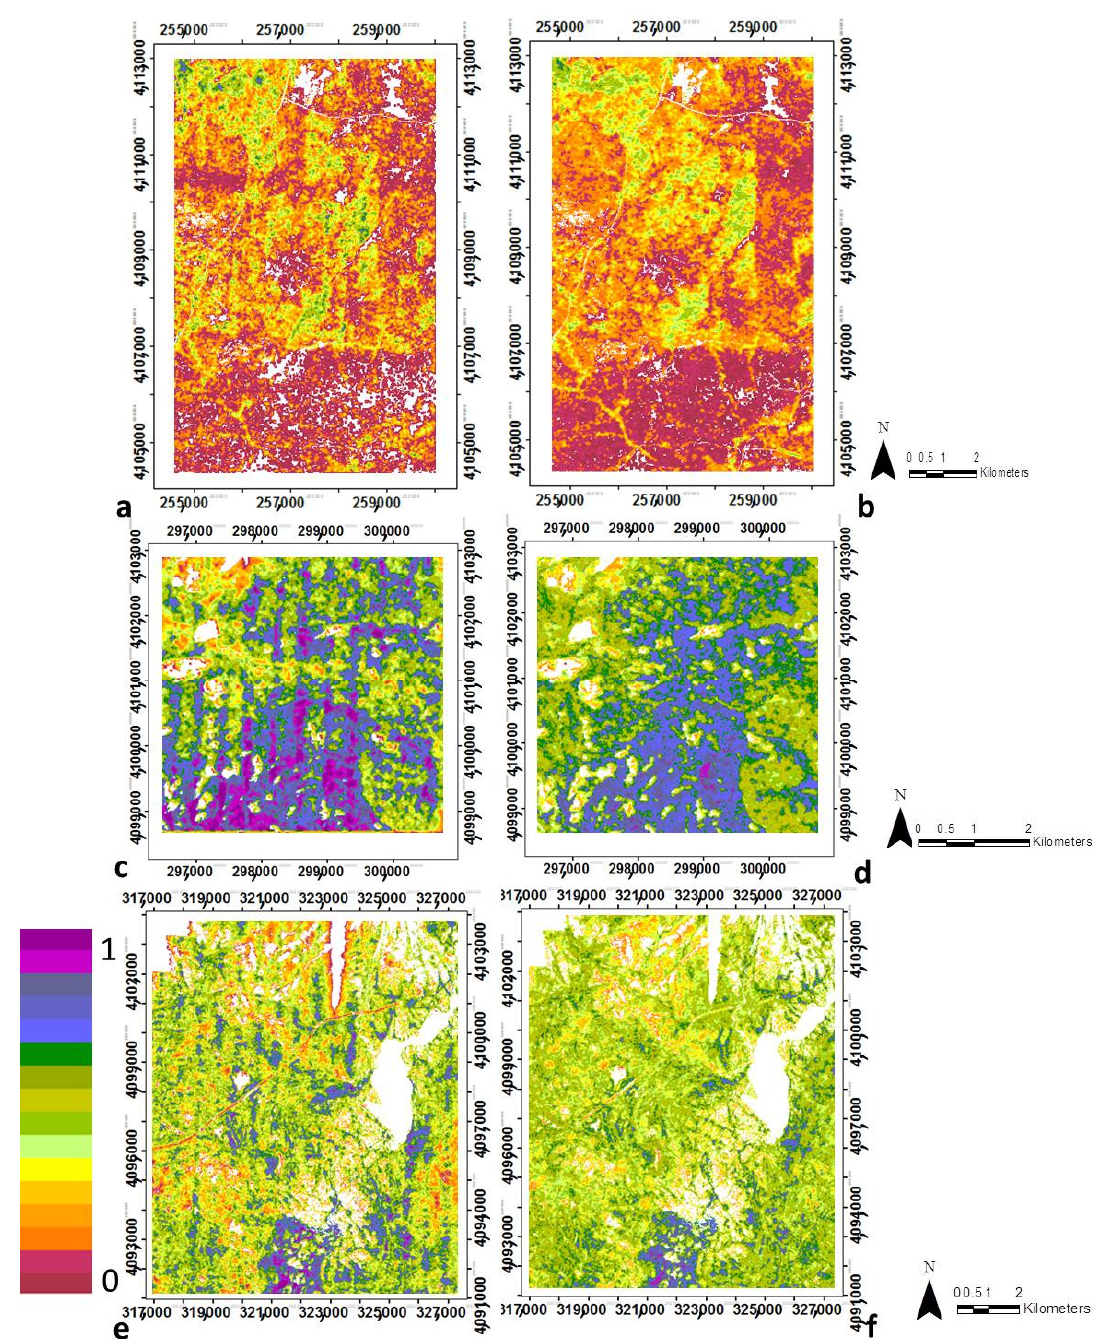
Figure 6. Spatial distribution of clumping from LiDAR-derived data ( a , c , e ) and from random forests regression using optical metrics ( b , d , f ), for SJER ( a , b ), SOAP ( c , d ) and TEAK ( e , f ). White areas are non-vegetated, either water bodies, rock, bare ground, etc. Note regions are not to scale due to optimizing images and site size differences. See Supplementary Materials, Table S5 for the ranking of the input metrics.